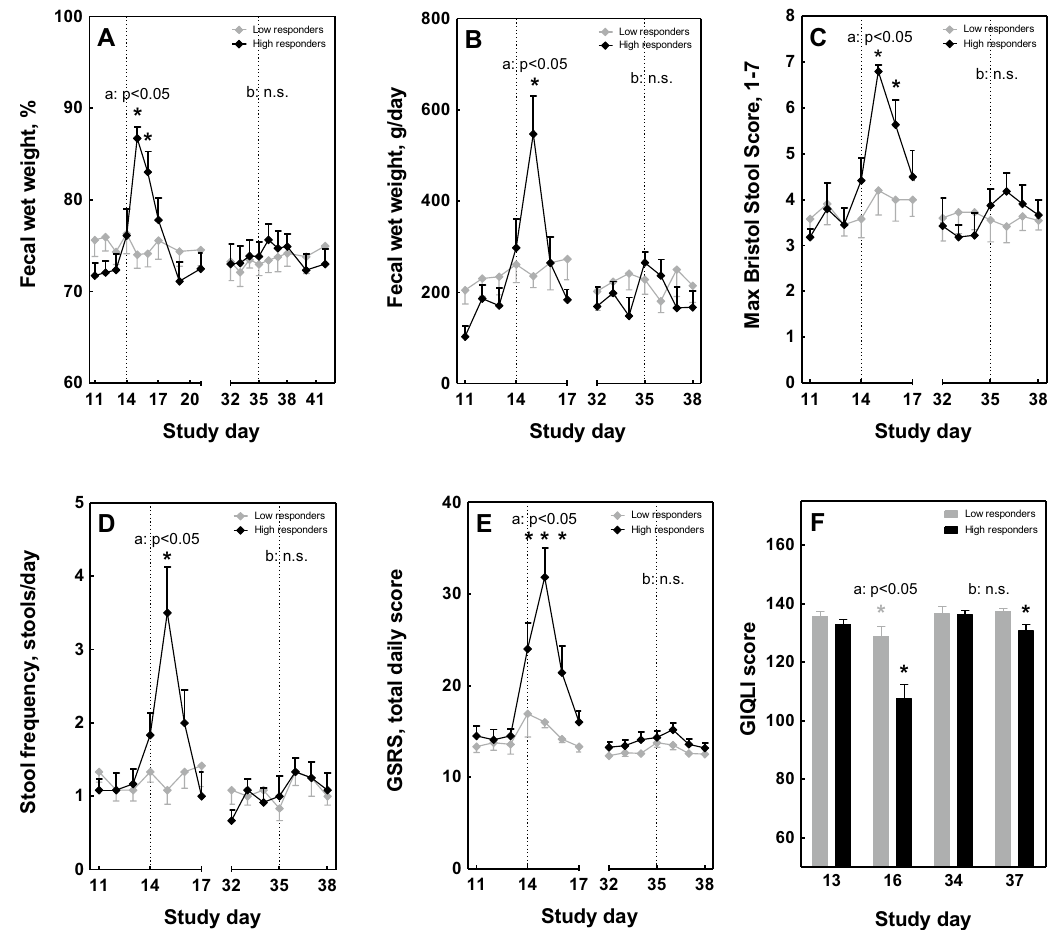
Figure 2. Effect of oral E. coli E1392/75-2A challenge in high- and low-responders on clinical parameters. Percentage and total fecal wet weight ( A , B ), stool consistency and stool frequency ( C , D ) and gastrointestinal disease-related symptoms and quality of life ( E , F ) were measured before and after infection with E. coli on study day 14 (strain E1392/75-2A; dose 1E10 CFU or 5E10 CFU). On study day 35, all subjects received a second inoculation of 1E10 CFU of E. coli (n = 42). Results are shown for a subset of high-responders (n = 12; black circles/bars) and low-responders (n = 12; grey diamonds/bars), selected based on ranking of a combination of clinical outcomes, and are expressed as means ± SEM. Timepoint at which significance is reached as compared to baseline day 13 (within the first infection period) or day 34 (within the second infection period) is indicated by *, with p < 0.05 within the specified group (repeated measures ANOVA; black *: within high-responders; grey *: within low-responders). Significant differences in the overall response between high- and low-responders (two- way ANOVA) are indicated separately for the first ( a , day 11–17) and second ( b , day 32–38) infection period; ns not